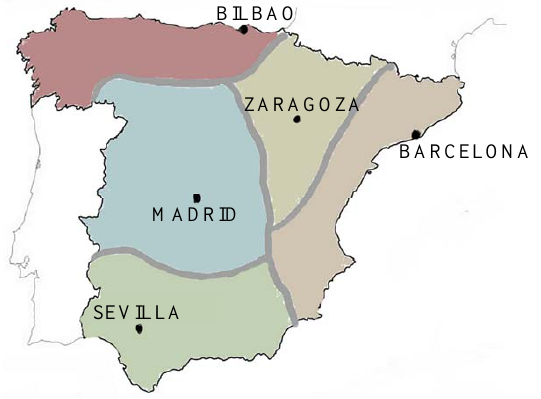
Figure 2. Location of the five temperature series and distribution of the weather regions in Spain.